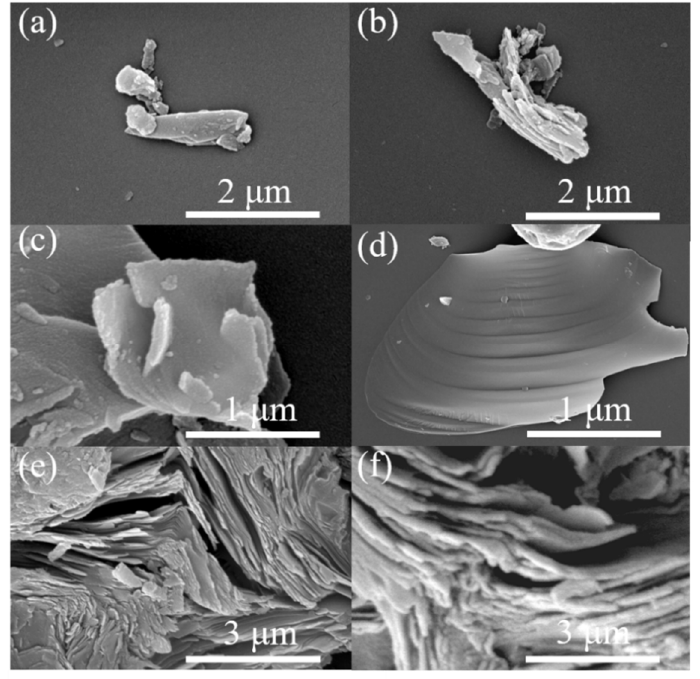
Figure 1. SEM images of ( a ) CuPc-600 ( b ) CuPc-700 ( c ) CuPc-800 ( d , e ) CuPc-900 ( f ) CuPc-900/HCl.